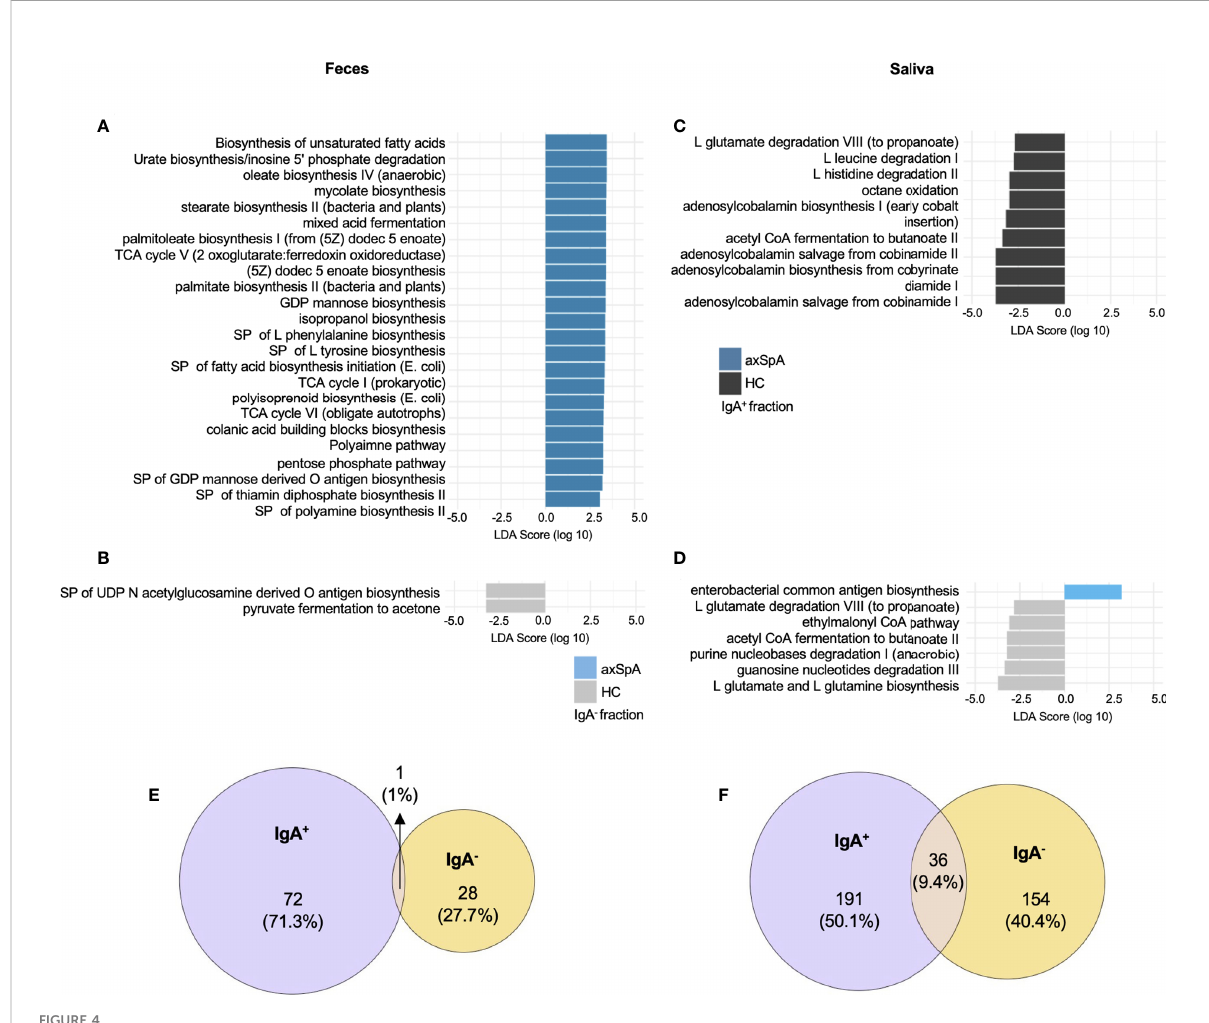
FIGURE 4 PICRUSt2 pathways and metabolites enriched in axSpA patients and healthy individuals. Linear Discriminant analysis (LDA) effect size analysis showing differentially abundant MetaCyc metabolic pathways between various groups shown in a bar plot in (A) IgA enriched and (B) IgA depleted fecal fractions comparing axSpA patients with HCs. The bar plots for salivary (C) IgA enriched and (D) IgA depleted fractions from axSpA patients in comparison with HCs are also shown. Predicted microbial metabolites (KO) in the (E) feces and (F) saliva. The data for both IgA + and IgA - fractions and their overlap as shown in area proportional Euler plots. Brie fl y, the numbers represent KOs signi fi cantly altered in their LDA score in axSpA patients in comparison with the HC in the IgA + fraction (purple) and IgA - fraction (yellow). MetaCyc pathways and KEGG metabolites (KOs) with a class level alpha<0.05 and subclass alpha<0.05 are considered signi fi cant. SP (superpathways), TCA (tricarboxylic acid), GDP (guanosine